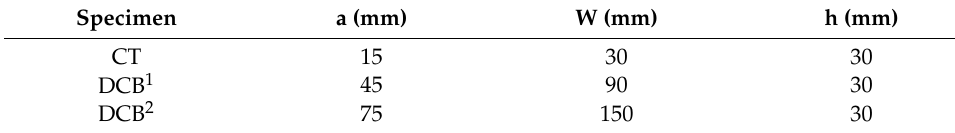
Figure 1. Schematic and main geometrical parameters of the different specimens. Table 1. Dimensions of CT, DCB 1 and DCB 2